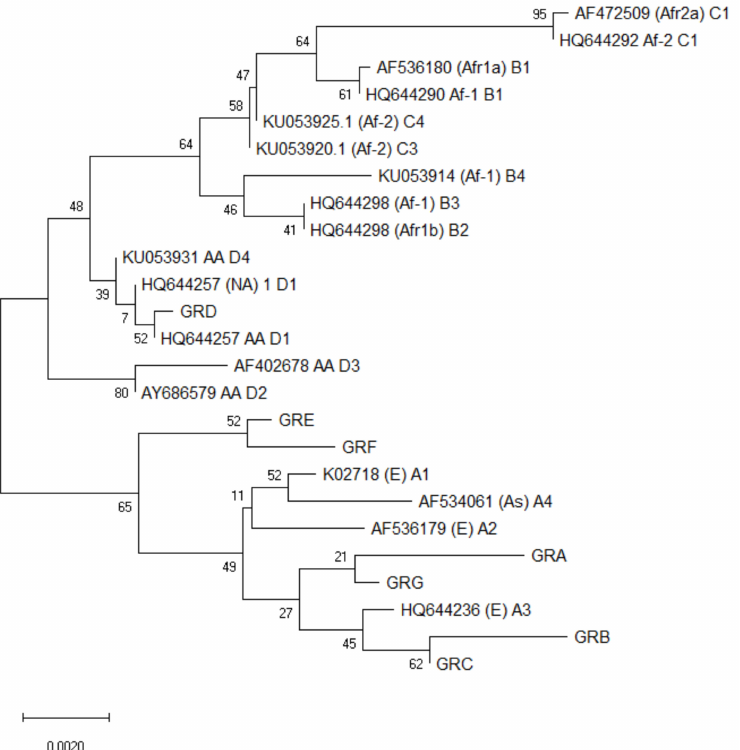
Figure 1. A Neighbor-Joining (NJ) phylogenetic tree (1000 bootstrap replicates) constructed using Kimura two-parameter correction methods of MEGA X, from the alignment of the HPV16 E6 sequence from sub-lineages A1, A2, A3, A4, B1, B2, B3, B4, C1, C3, C4, D1, D2, D3, D4 and HPV16 E6 sequences from the present